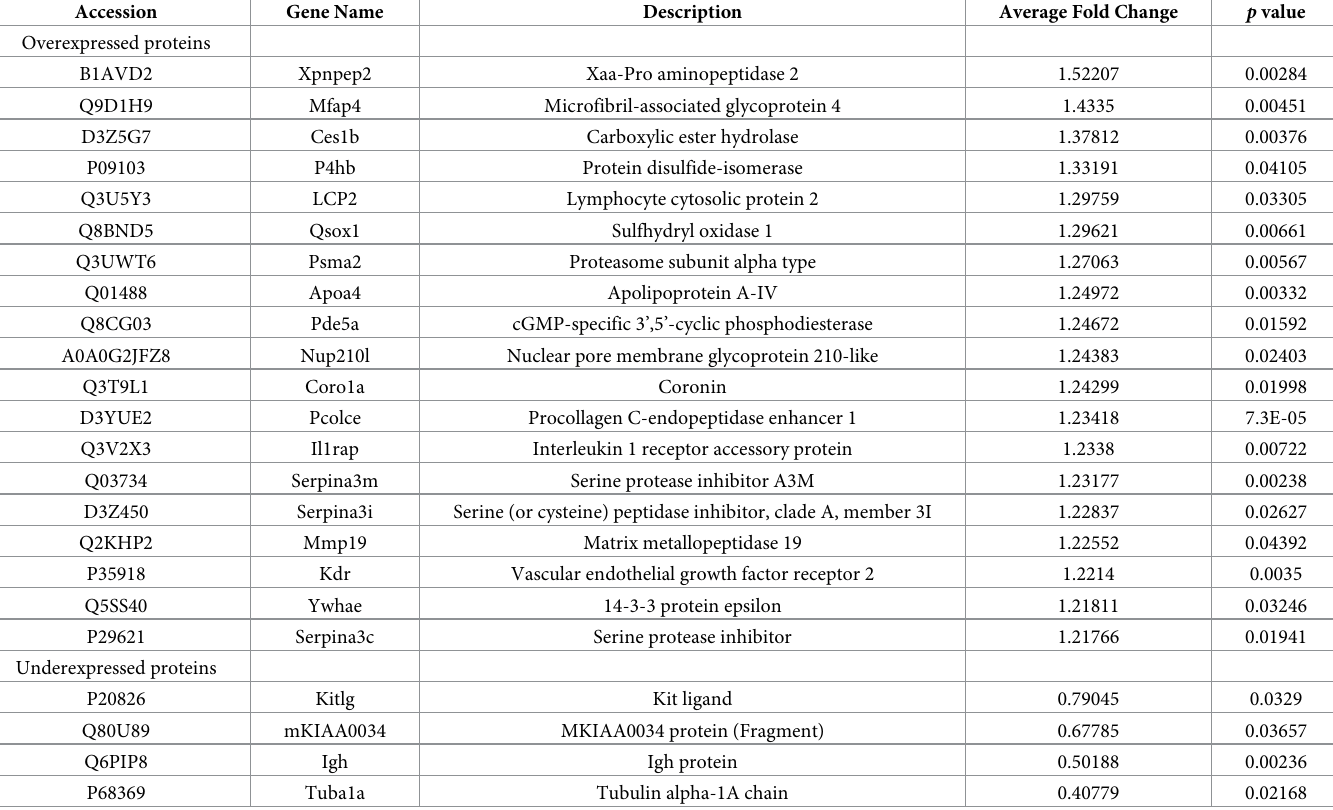
Table 1. Differentially expressed proteins identified by iTRAQ